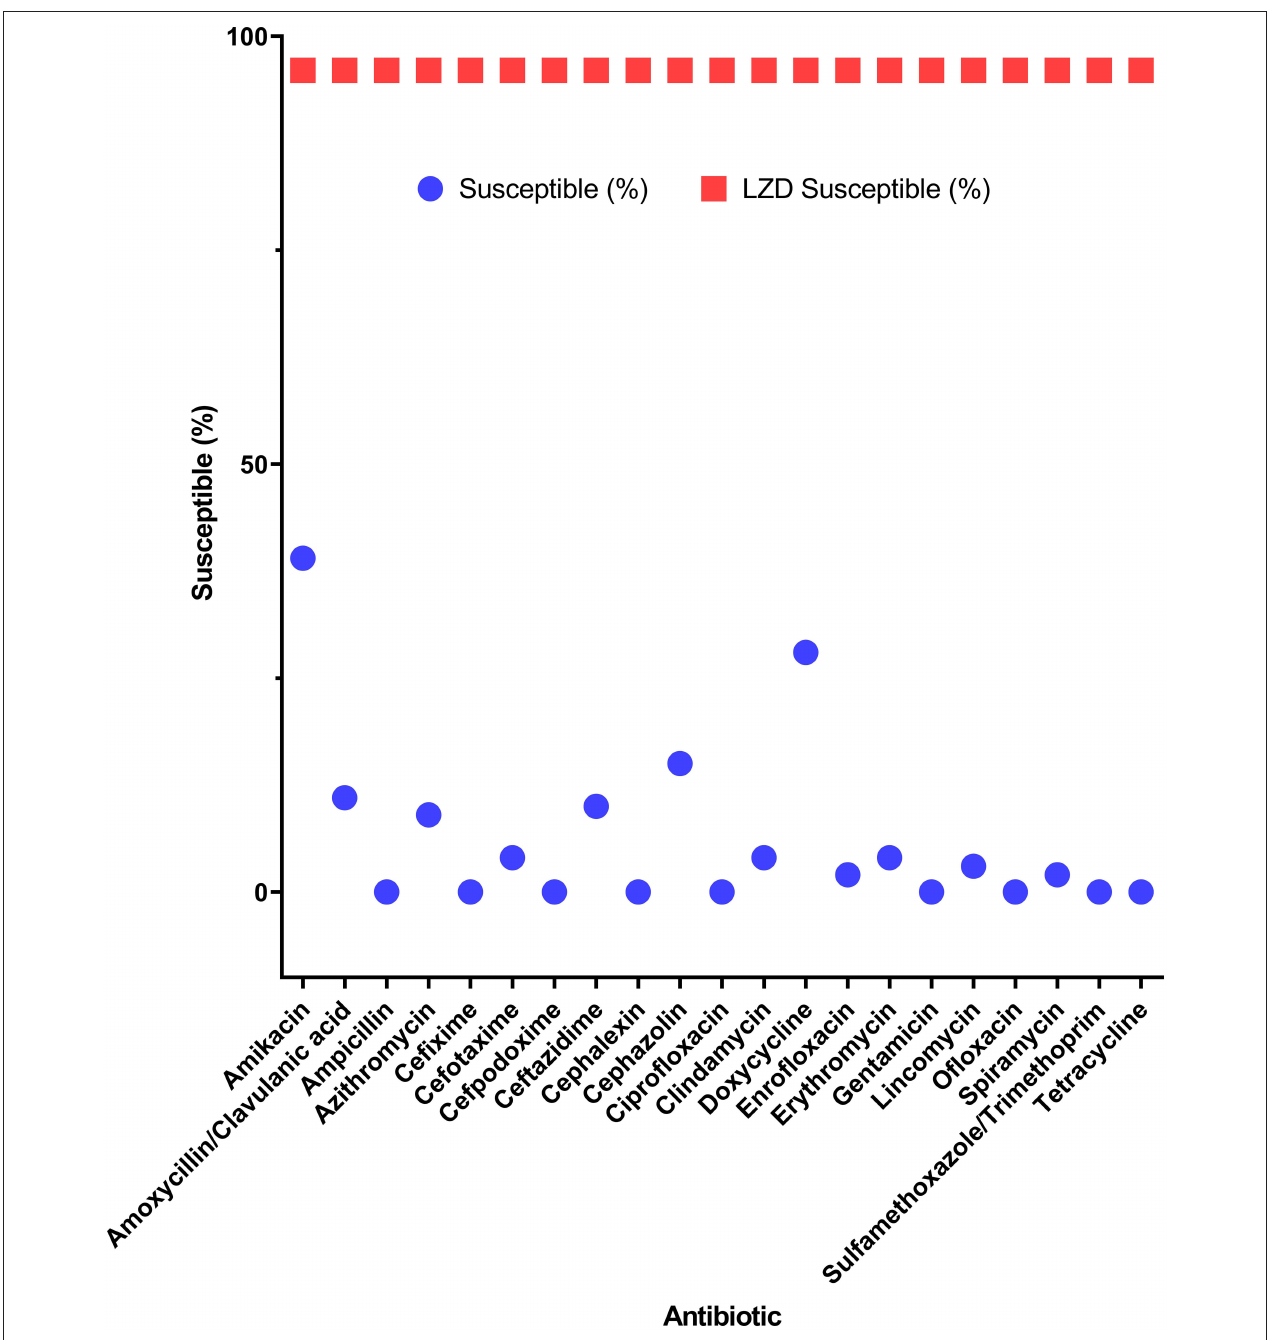
FIGURE 1 | Efficacy of linezolid compared to 21 antibiotics for potential pan-drug-resistant (PDR) bacteria from dogs. Circles indicate the susceptibility of gram-positive potential PDR isolates for each antibiotic. Squares indicate the average susceptibility of gram-positive potential PDR